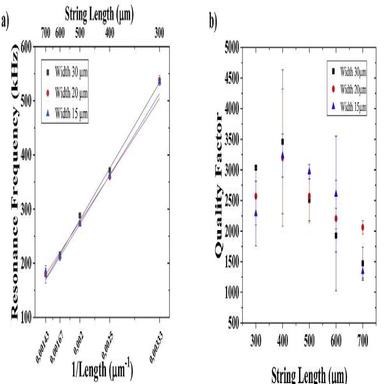
Resonance frequency (a) and Q factor (b) of fully suspended pyrolytic carbon string resonators. Data is presented as mean ± SD (n = 5).